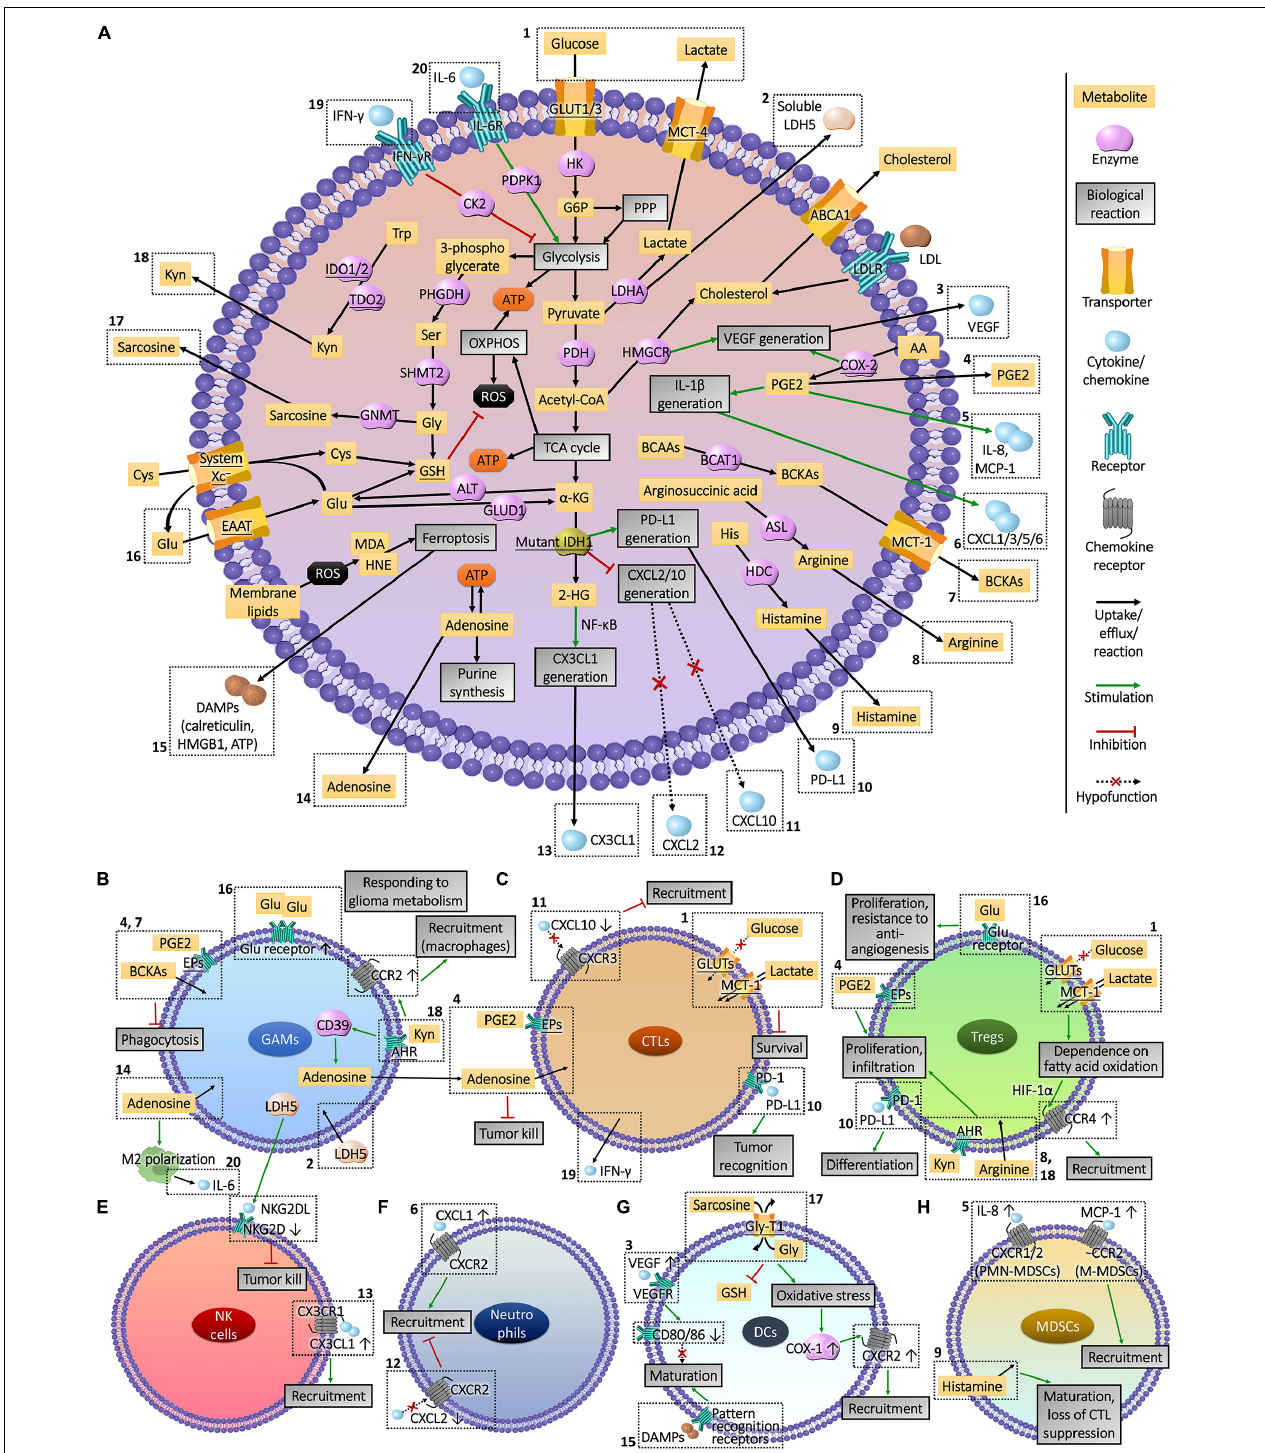
FIGURE 3 | Interactions between glioma cell metabolism and immunomicroenvironment. (A) Metabolic reprogramming enables glioma cells to express high levels of substrate transporters and metabolic enzymes to obtain sufficient energy in the harsh conditions of lesion, resulting in the deprivation of nutrient substrates and accumulation of immune-interfering metabolites in the extracellular fluid. Abnormally expressed or mutated metabolic enzymes also affected immune cells by regulating the production of chemokines and other cytokines. The actions of these molecules that enter the tumor microenvironment on immune cells and the influences of immune cells on glioma cells metabolism are presented in part (B–H) . The Arabic numerals in the figure link the metabolism of glioma cells (A) with immune cells (B–H) .